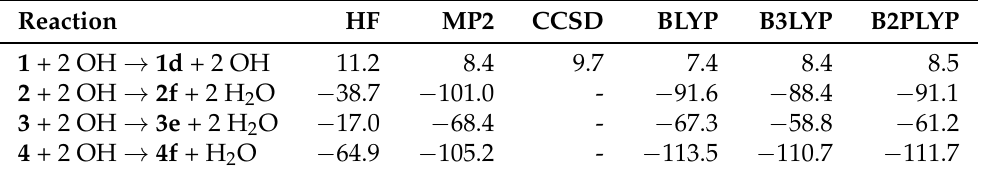
Table 1. Reaction energies in kcal/mol computed with Hartree–Fock, post-Hartree–Fock and DFT